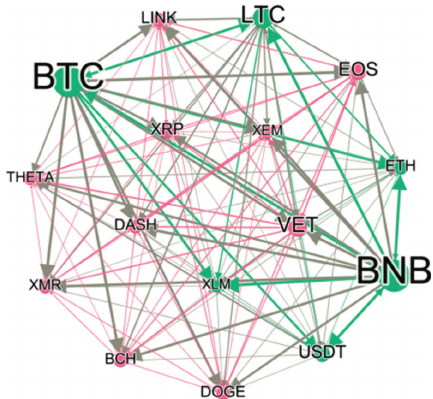
Figure 31: Risk spillover under D6.